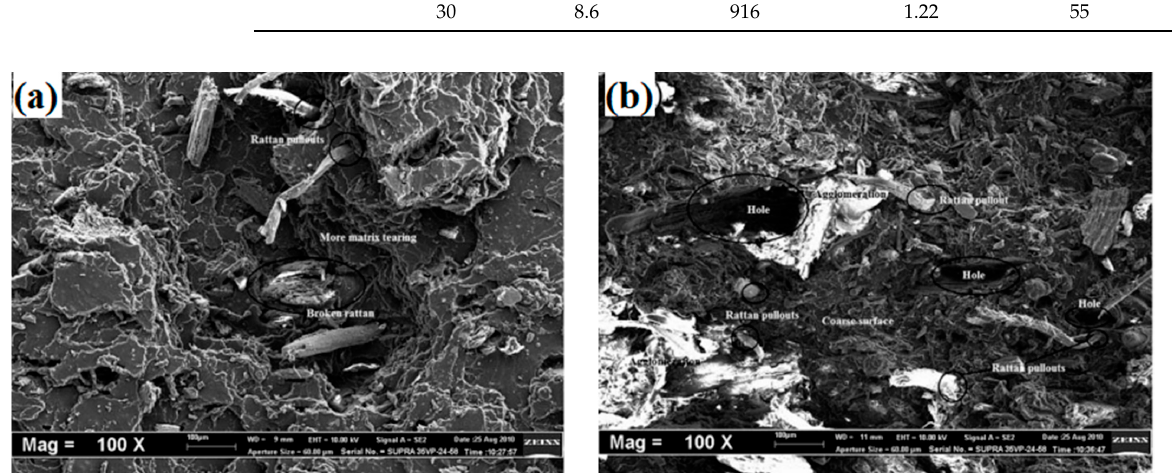
Figure 2. SEM micrographs of the tensile fracture surface of NR composites filled with ( a ) 5 phr and ( b ) 30 phr rattan powder (reproduced with permission from [25]). ( b ) 30 phr rattan powder (reproduced with permission from